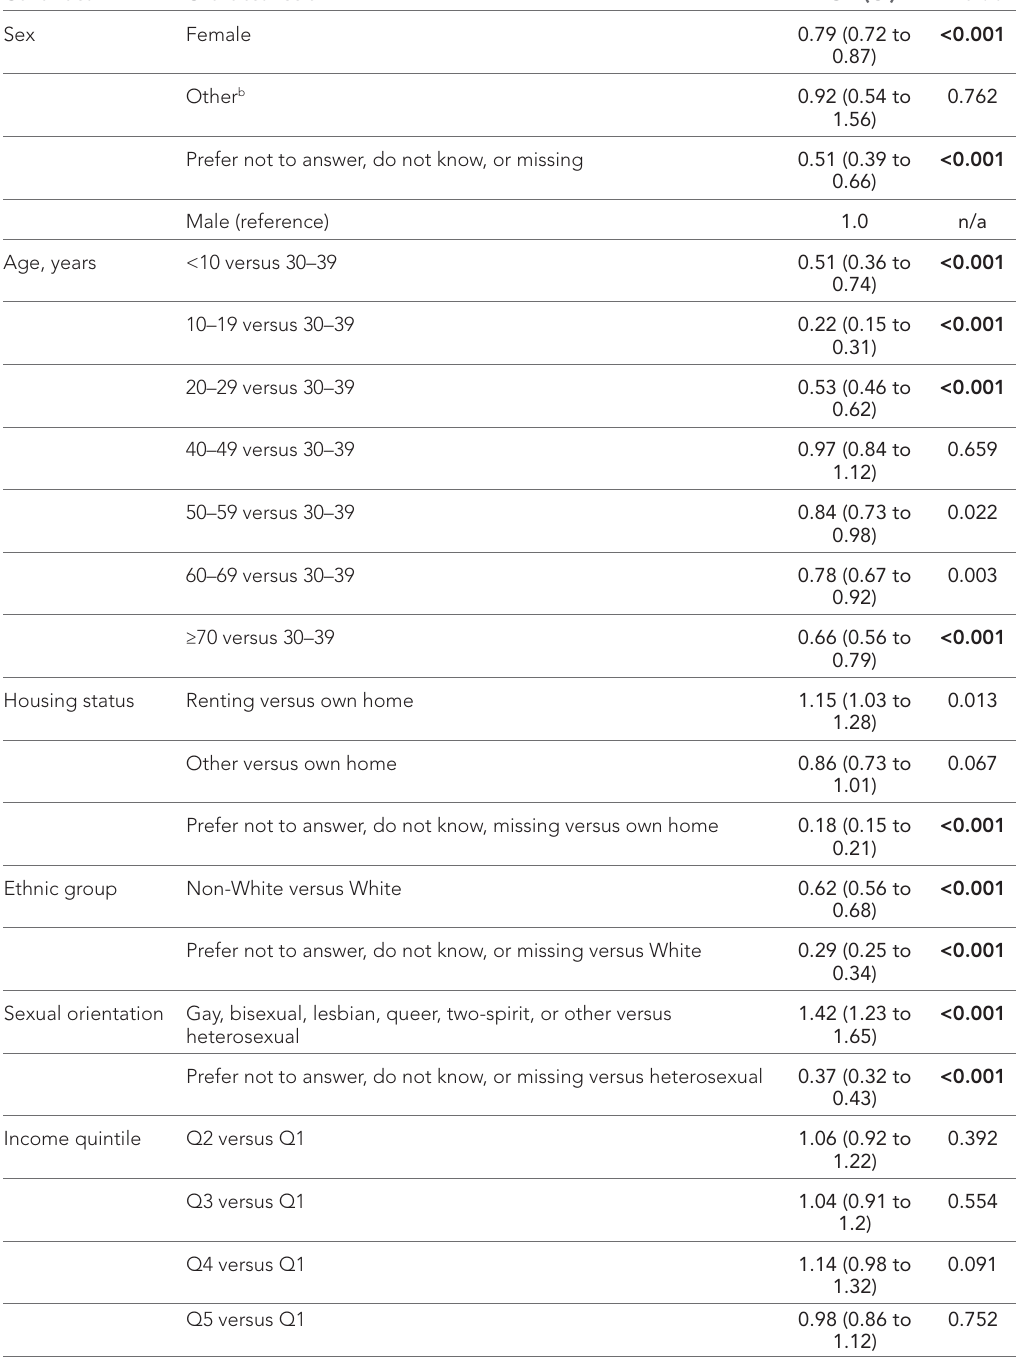
Table 2 Adjusted odds of responding to a two- part question on income Covariate